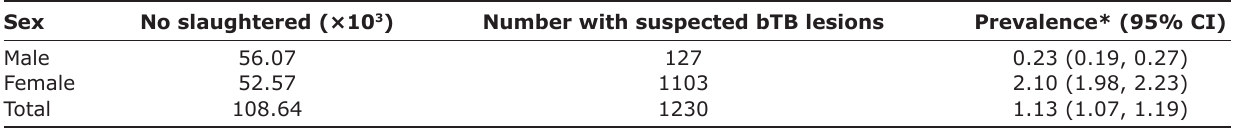
Table-2: Sex-wise prevalence of bTB gross lesions among slaughtered cattle in Bauchi municipal abattoir, Nigeria (2004-2013).